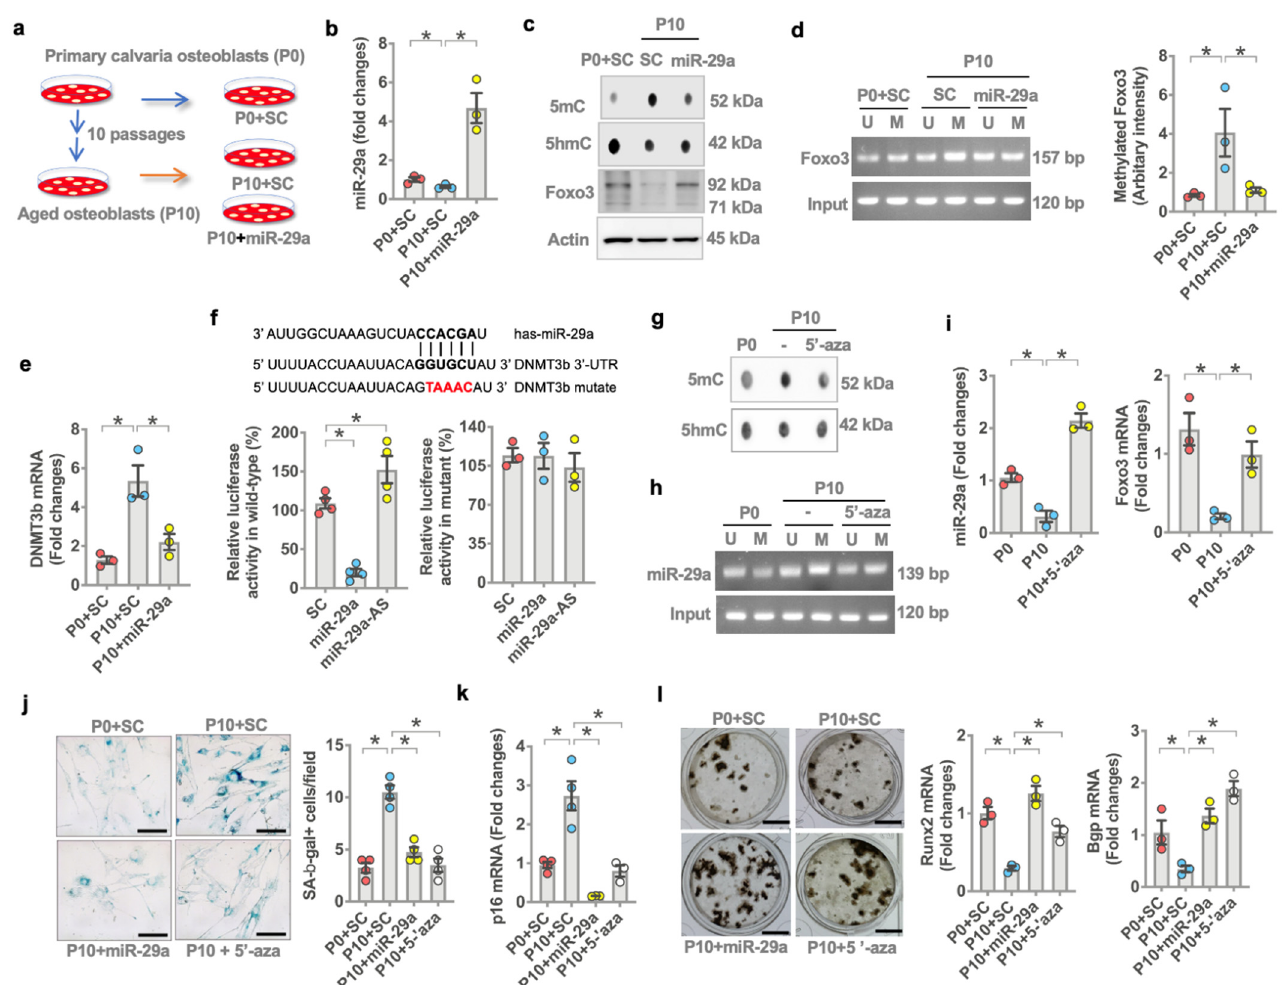
Figure 6. Effects of miR-29a on FoxO3 promoter methylation and Dnmt3b expression in aged osteoblasts. Schematic drawing for a model of multiple passages-induced osteoblast aging ( a ). Forced miR-29a expression reversed miR-29a ( b ) and FoxO3 levels but decreased 5mC levels ( c ) and FoxO3 promoter methylation ( d ) in multiple-passaged osteoblasts. miR-29a attenuated ( e ) Dnmt3b expression ( e ) and luciferase reporter activity of 3 ′ -UTR of Dnmt3b ( f ). 5-aza decreased 5mC levels ( g ) and miR-29a promoter methylation ( h ), reversing miR-29a and FoxO3 expression ( i ) in multiple passage osteoblasts. miR-29a or 5-aza compromised multiple-passage-induced SA- β -gal activity ( j ) and p16 expression ( k ), improving mineralized matrix production and Runx2 and Bgp expression ( l ). Significant differences (asterisks *) of investigations (mean ± standard error, n = 3–4 experiments) were analyzed using an ANOVA test and a Bonferroni post hoc test. SC, scramble control; U, unmethylated amplicons; M, methylated amplicons. AS, antisense oligonucleotide; 5-aza, 5 ′ -azacytosine.